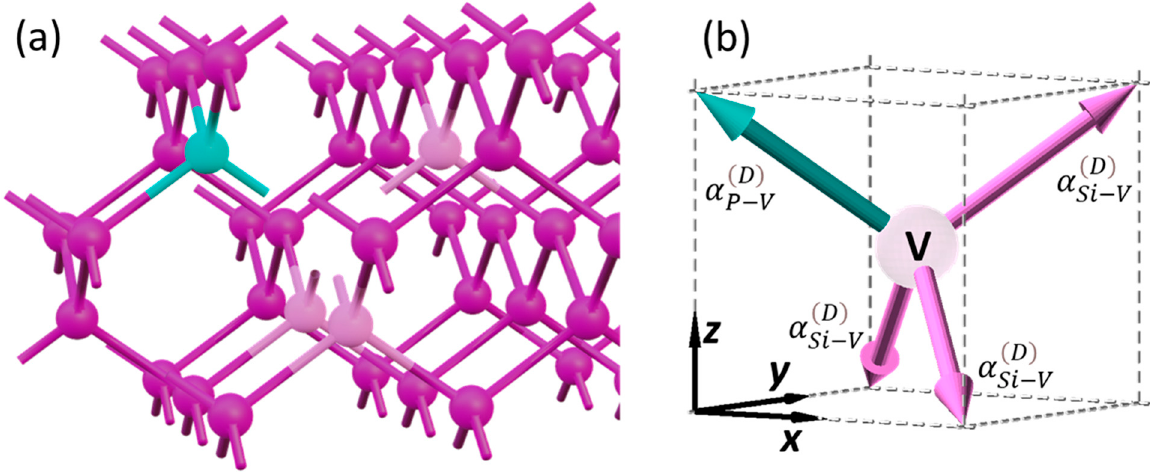
Figure 3. ( a ) The structure of a P 1 V cluster, where the Si and P atoms are colored in pink and cyan, respectively, and the P atoms neighboring the vacancy are colored in light pink. ( b ) A vacancy cell with the corresponding bond vector structure.